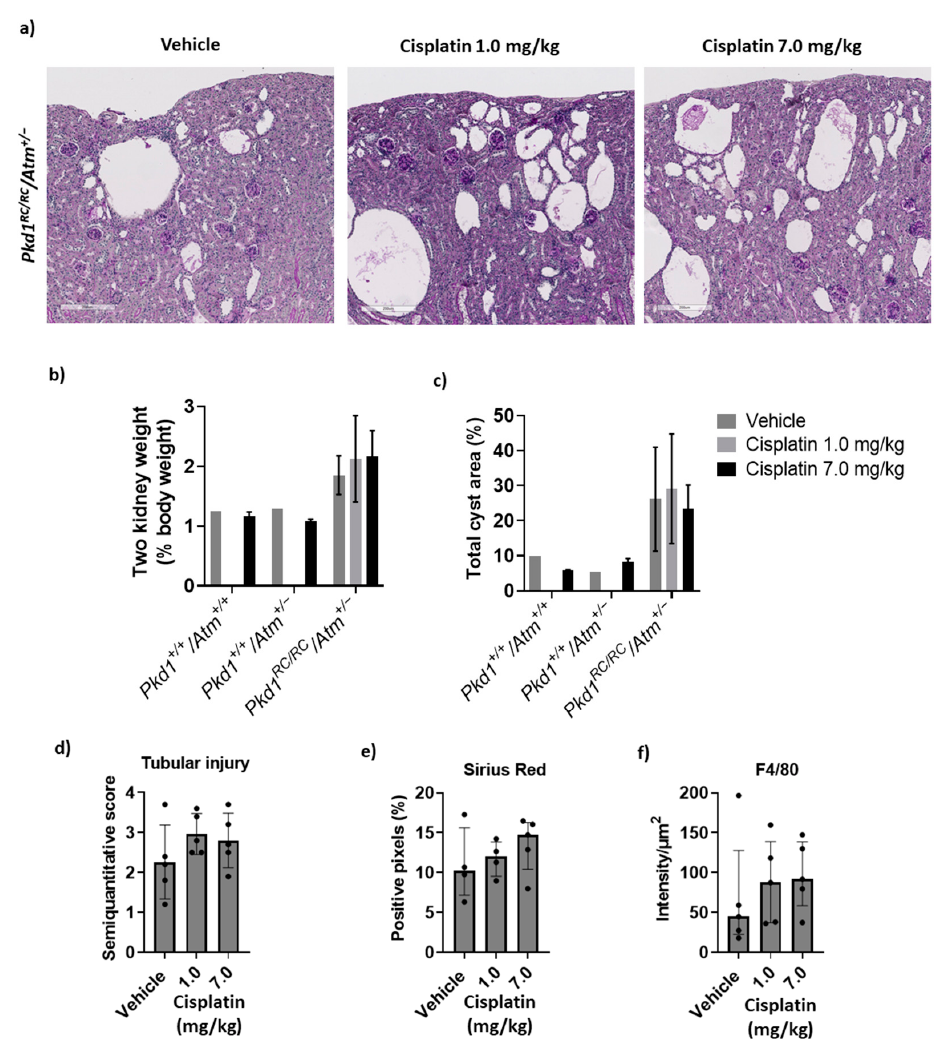
Figure 3. Long-term effects of cisplatin on tubular injury and cyst growth. ( a ) Morphology of outer cortical region of mice treated with vehicle, cisplatin 1.0 mg/kg or cisplatin 7.0 mg/kg; ( b ) two-kidney weight as a percentage of body weight at sacrifice; ( c ) cyst area in outer cortical region (scale bars = 200 µm); ( d ) semiquantitative score of tubular injury; ( e ) quantification of collagen deposition by Sirius red staining showing strong positive pixels per µm 2 ; ( f ) quantification of F4/80 immunostaining showing strong positive pixels per µm 2 . Graphs showing median values with error bars representing upper and lower quartiles.